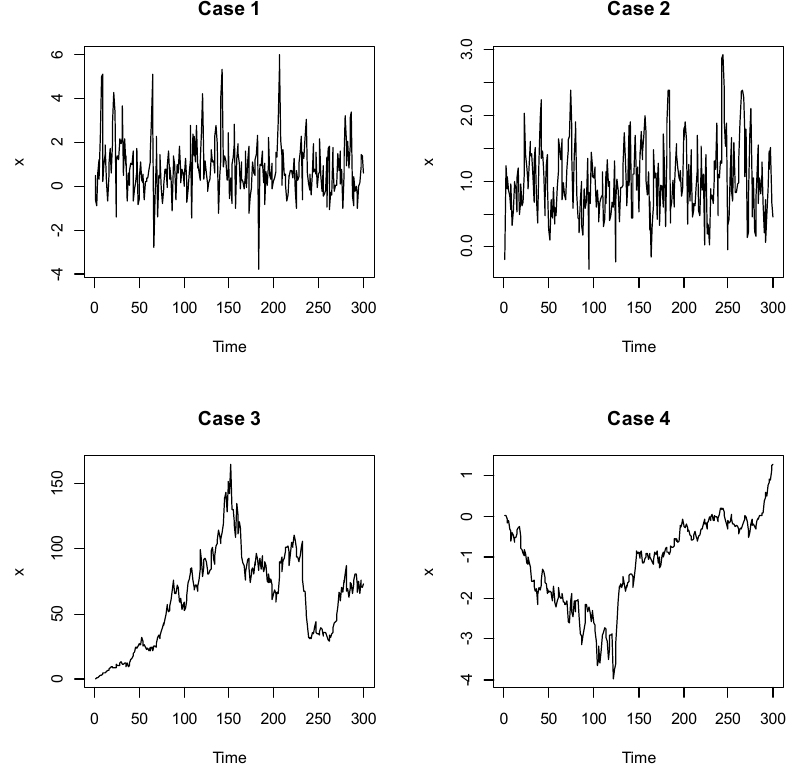
Figure 2. The time series plot of Case1–4 for generated data (300 sample sizes).